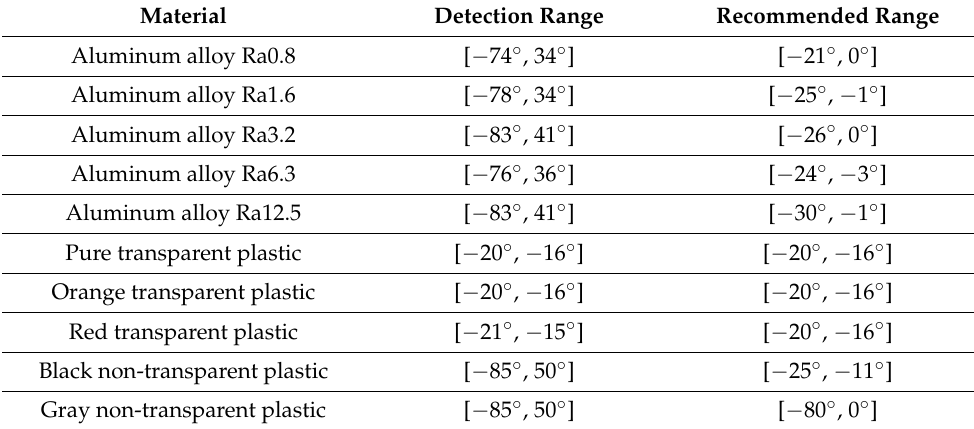
Table 7. Detection range of the laser line for all materials. The recommended range provides the highest reflection intensity, based on the experimental